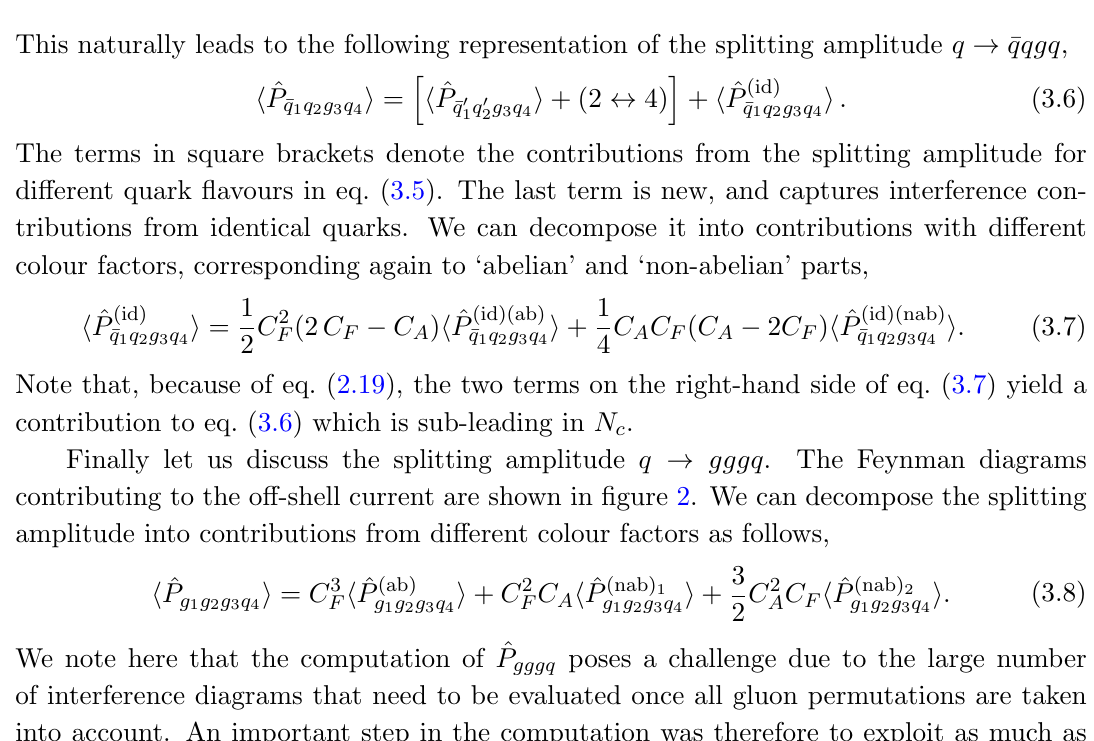
q ′ g 3 q 4 . In the case 1 2 and q 4 2